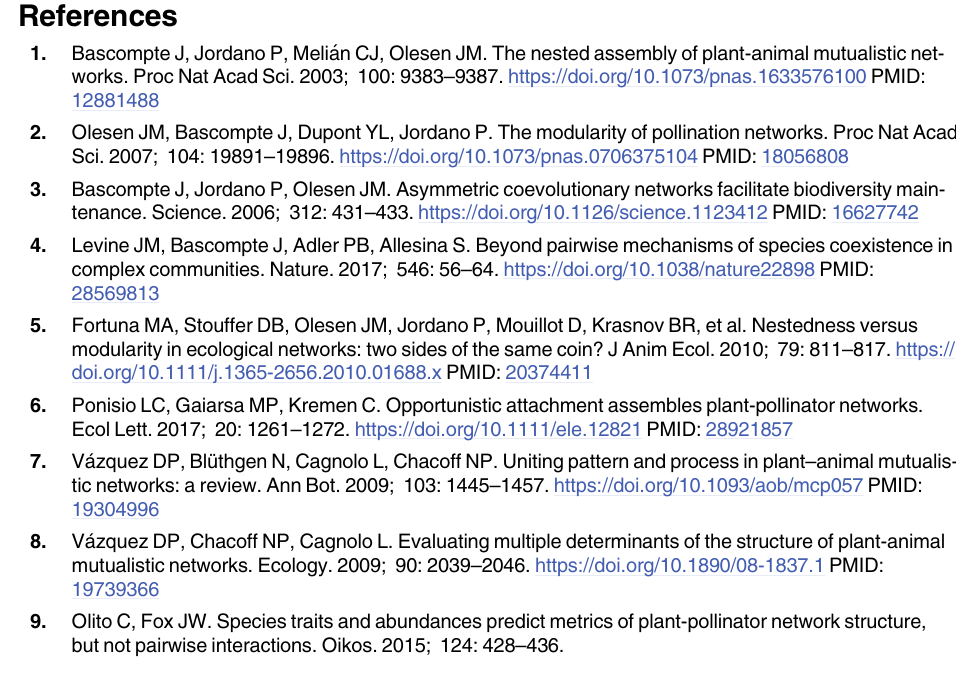
S1 Table. The skewness of frequency distribution of relative species abundance in both plant and pollinator communities.